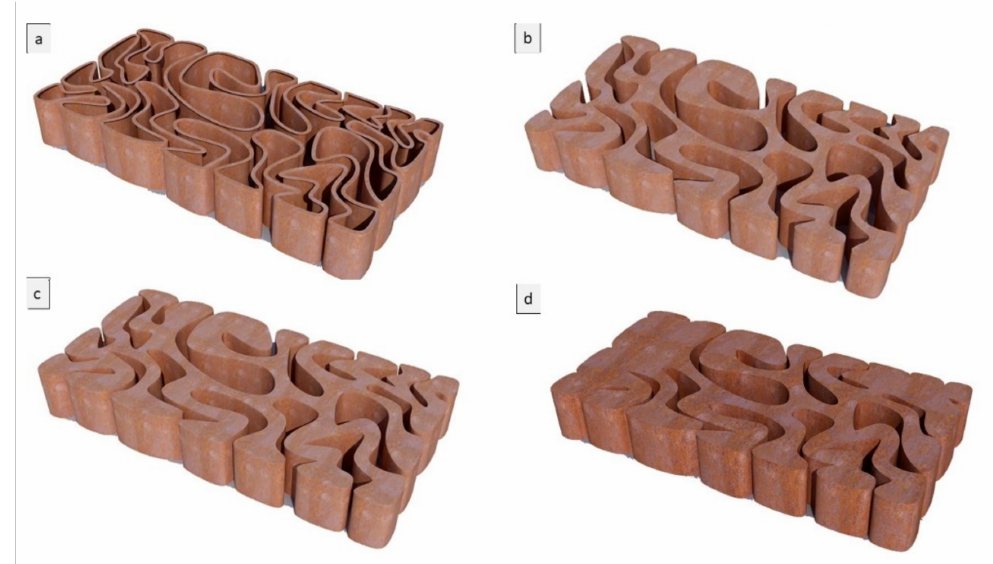
Figure 7. Alberto T. Est é vez (Yomna K. Abdallah, computational designer), Biodigital Barcelona Bricks (3D-printed clay), GENARQ/iBAG, UIC Barcelona. V3 design iteration of the Biodigital Barcelona Bricks showing the bricks’ varied material density from a linear model of 0.5 cm thickness to a bulk model ( a – d ), with the density of the bricks varying from 25% to 55% and 75%. Images by the